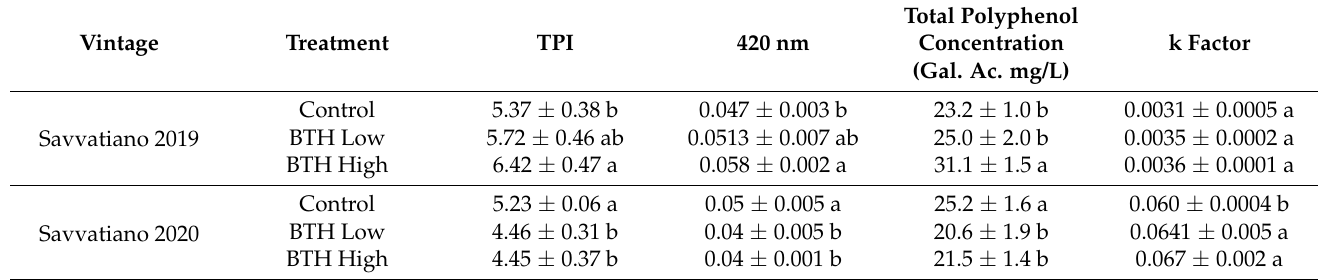
Table 4. Color and phenolic parameters of the three experimental Savvatiano wines in response to two different